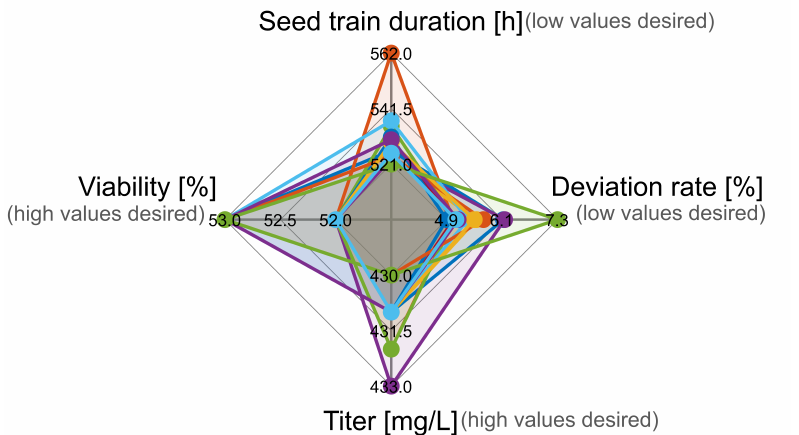
Figure 9. Spider plot showing the objective criteria values (seed train duration, deviation rate, titer and viability after 8 days in the production vessel) for the Pareto optimal solutions for 5 shake flask